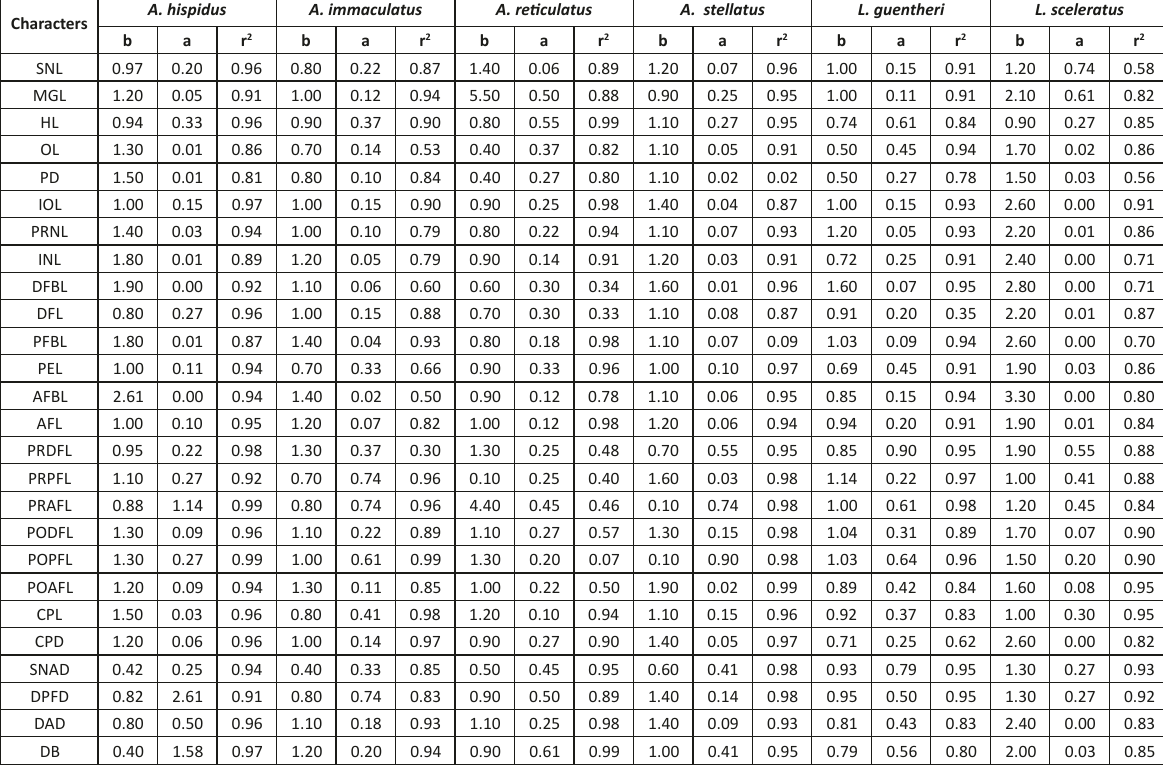
Table 3a. The relationship between all the characters and standard length of Tetradontidae from southeastern India, P<0.01. Characters